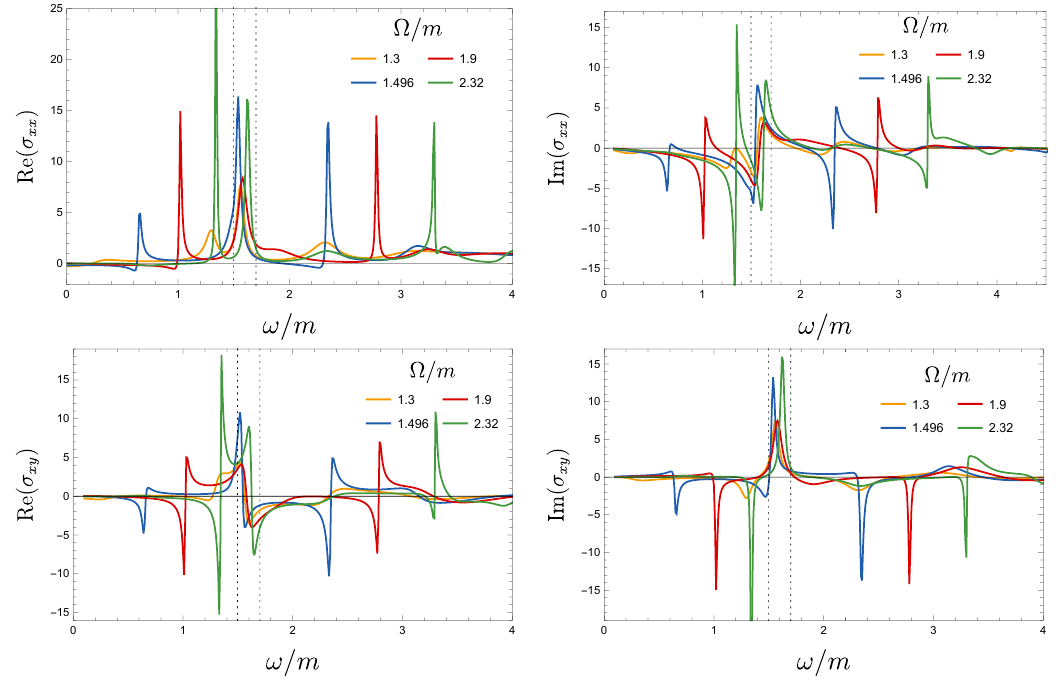
Figure 11 . Peaks in the AC conductivities closely above along the critical line. The exact position of these curves in phase space can be seen in (cid:12)gure 12 as coloured circles. The vertical dashed lines signal the vector meson Floquet condensate and the meson mass frequencies respectively. The central peaks bunch in this region whereas the two lateral peaks move with ! while keeping their separation almost constant, (cid:1) !=m (cid:24) 1 : 7.